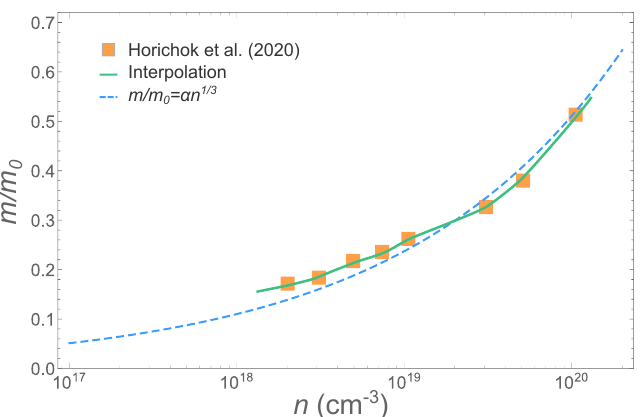
Figure 4: The effective mass of electrons as a function of the concentration for PbTe. The orange squares showcase the experimental data [ 29 ] , the green line illustrates our interpolation employed in further calculations and the dashed blue ∼ α n 1 / 3 with α ≈ 1.1 · 10 − 7 line approximates tha data with a scaling m / m 0